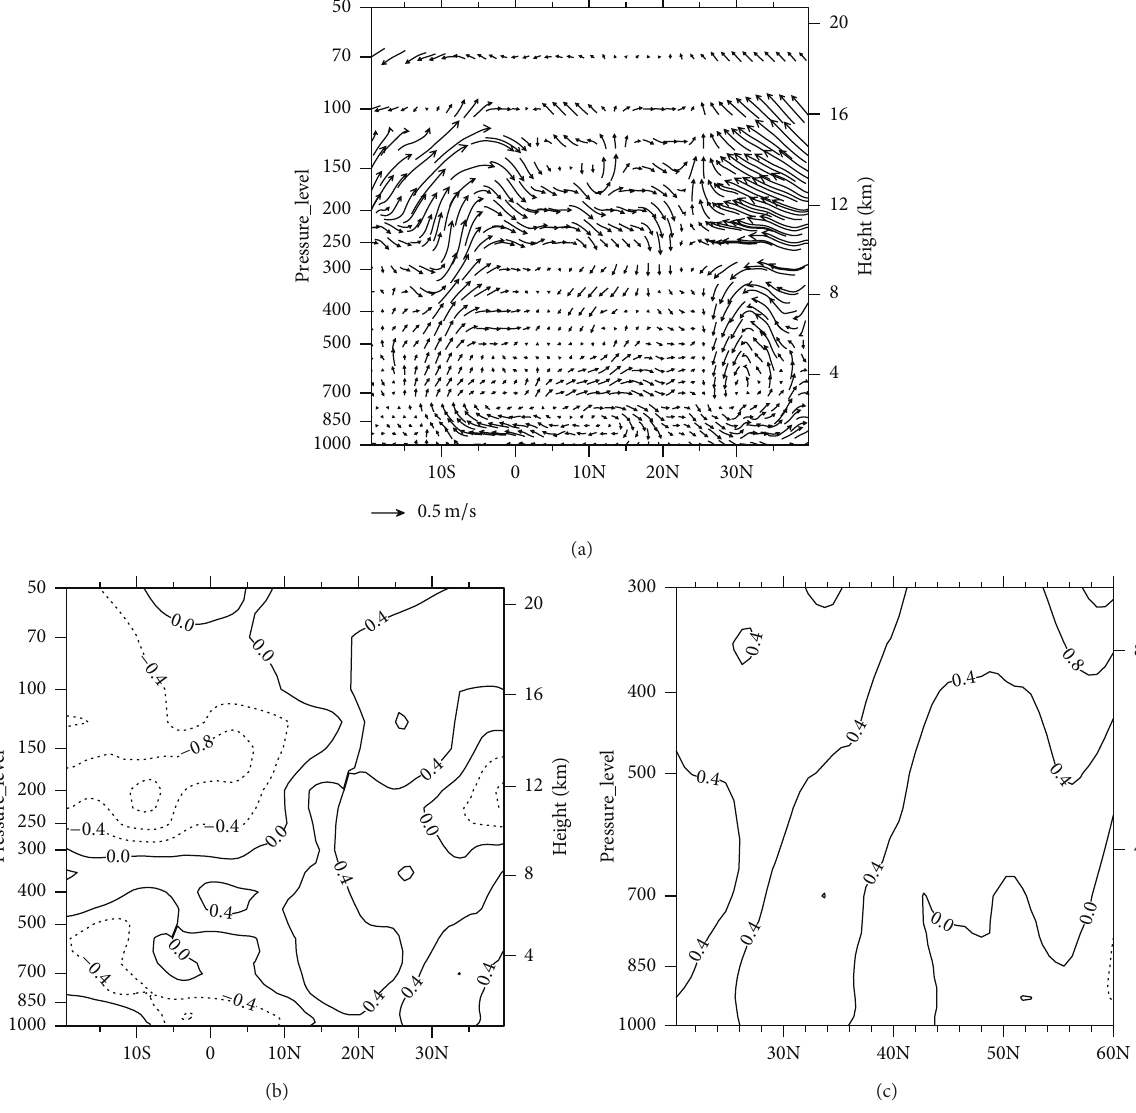
Figure 8: The pressure-latitude profiles of v-w wind anomaly (m/s) in (a) West Pacific (110 ∘ E–180 ∘ E) and v-component anomaly (m/s) in (b) Southeast Asia (90 ∘ E–130 ∘ E) and (c) Northeast Asia (90 ∘ E–130 ∘